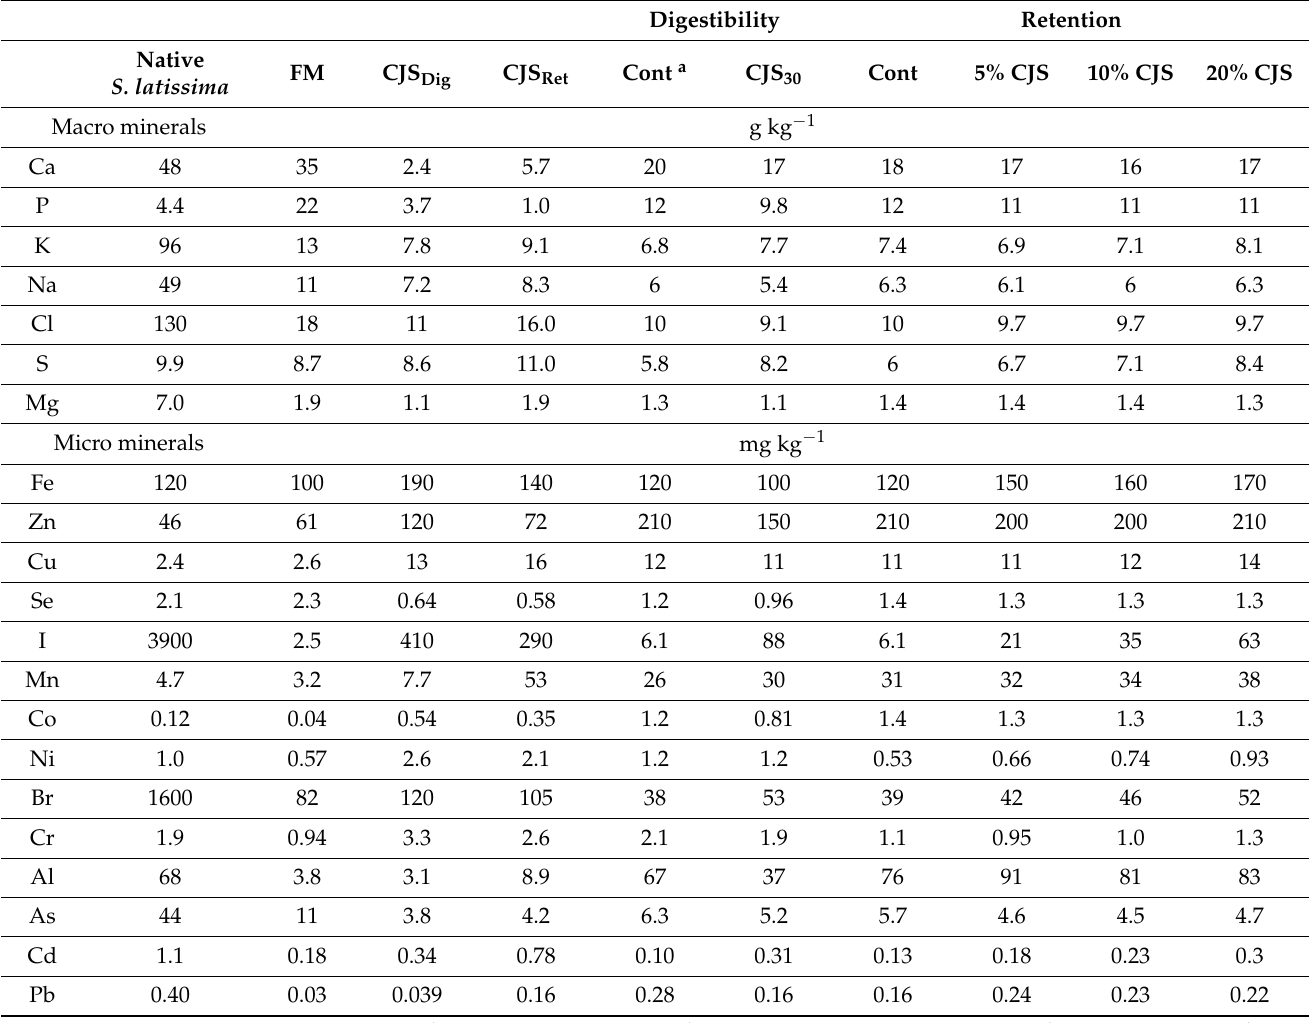
Table 1. Macro and micro minerals present in the native Saccharina latissima, Cyberlindnera jadinii (CJS, produced from S. latissima and woody hydrolysates) used in either the digestibility (CJS Dig ) or the retention experiment (CJS Ret ) with Atlantic salmon ( Salmo salar ) and the fishmeal used in both experiments. Mineral composition of diets used in either the digestibility (Cont and CJS 30 ) or the retention experiment with Atlantic salmon fed increasing level of